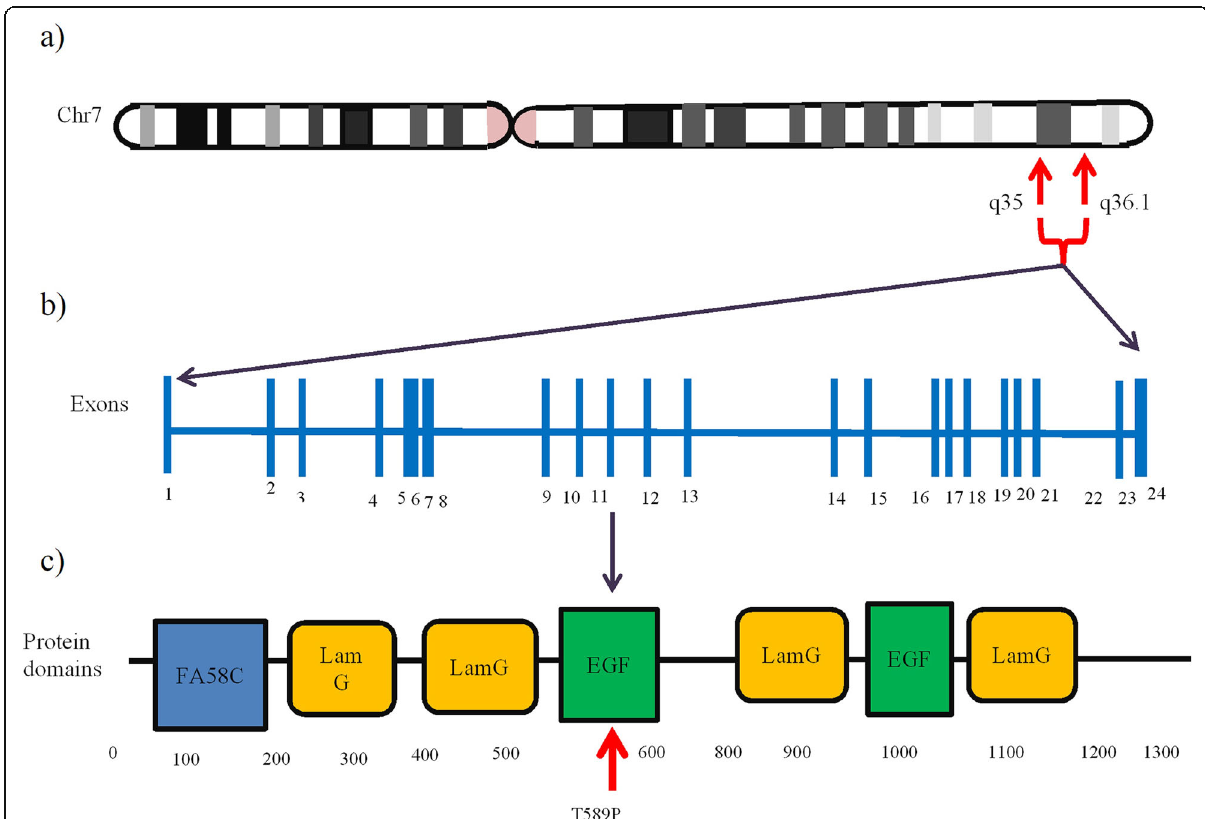
Fig. 3 Schematic gene structure of CNTNAP2 with the unique T589P variant marked with the mapped protein